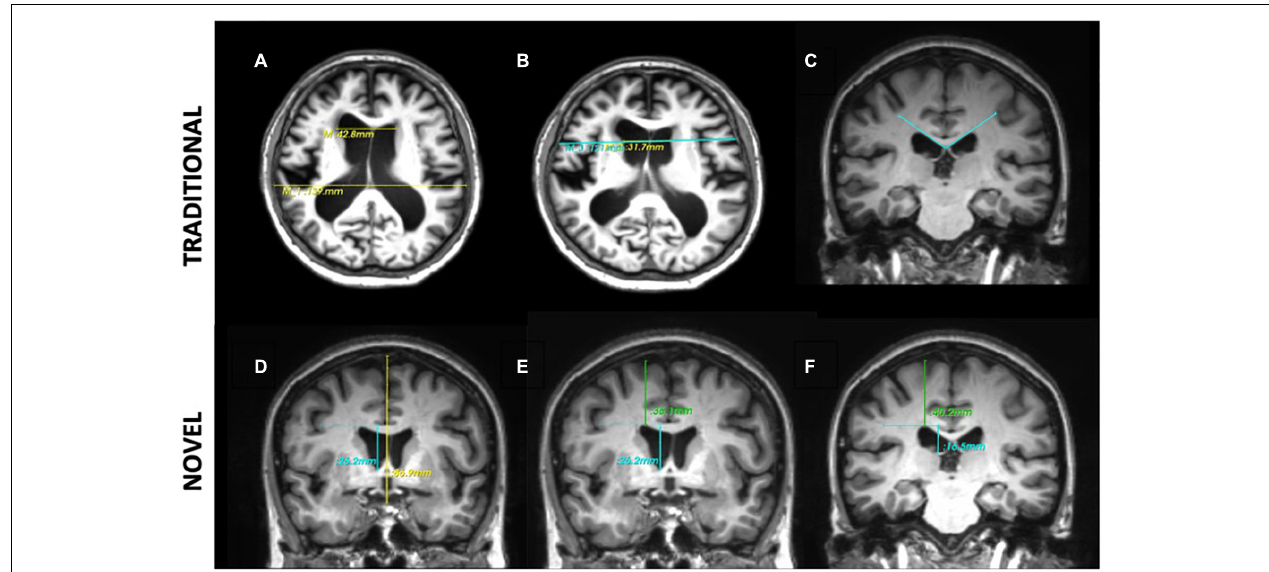
FIGURE 1 | Morphological indices. Traditional 2-dimensional (2d) linear measures: (A) Evans Index is the ratio of the maximal width of the frontal horns of the lateral ventricles (top line) to the maximal width of the internal diameter of the cranium (bottom line). (B) Bicaudate Index is the ratio of the maximum intercaudate distance (yellow line) to the width of the brain along the same line on the axial plane (blue line). (C) The callosal angle is measured as the angle of the corpus callosum through the posterior commissure perpendicular to the ACPC plane. Novel 3-directional (3d) linear measurements: (D) the z-Evans index is the ratio of the maximum z-axial length of the frontal horns of the lateral ventricles (blue line) to the maximum cranial z-axial length on the coronal plane (yellow line), perpendicular to the ACPC plane, on the anterior commissure. (E,F) The Brain-Ventricle-Ratios (BVRs) measured at the level of the anterior and posterior commissure, respectively, are measured as the maximal brain thickness above the lateral ventricles (blue line) divided by the maximum length of the lateral ventricles (green line), on the coronal plane.